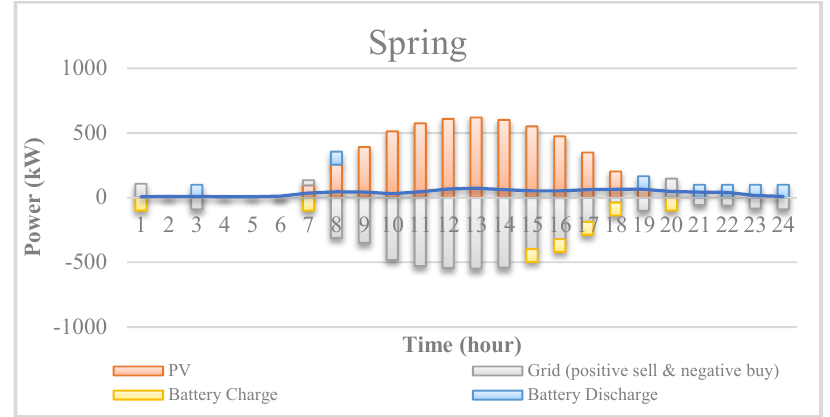
Figure 16. The bidding power of the VPP in spring.